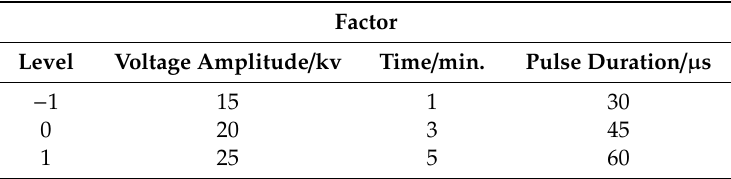
Table 2. Pulsed electric field (PEF) orthogonal test factor level